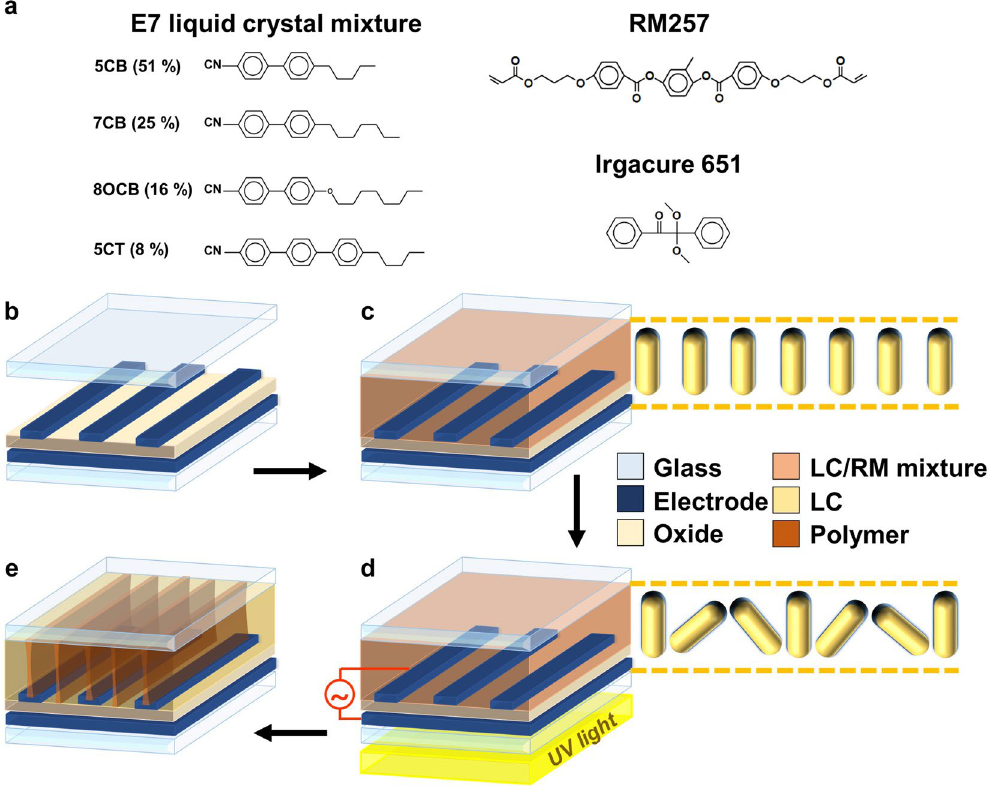
Figure 2. ( a ) Chemical structures of the used materials. Photopolymerization process for the fabrication of an LC cell with polymer walls: ( b ) preparation of an empty cell with double-layered electrodes, ( c ) injection of an LC/RM mixture into an empty cell, ( d ) UV exposure for polymerization under an applied in-plane electric field, and ( e ) completion of an LC cell with polymer